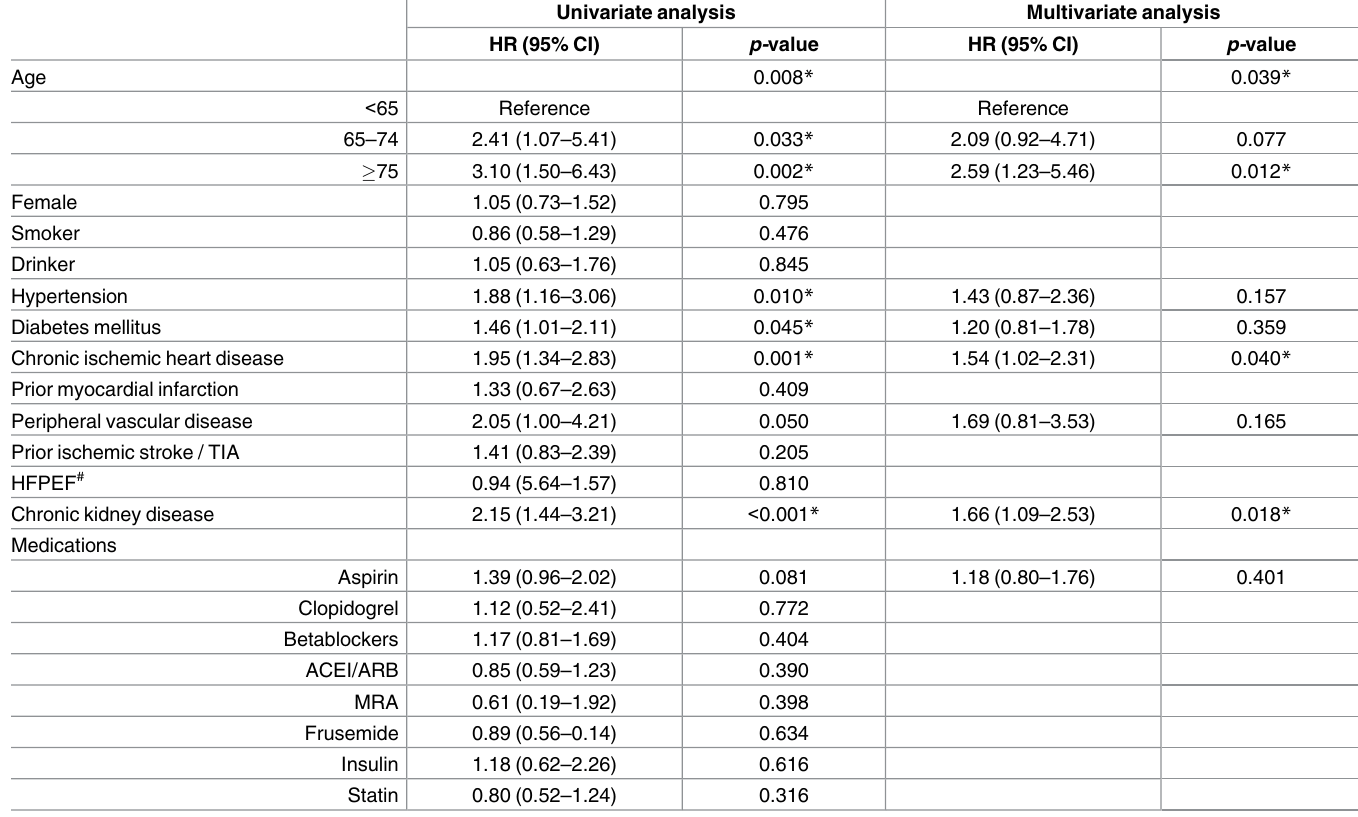
Table 2. Univariate and multivariate predictors of thromboembolic events in 1,202 heart failure patients in sinus